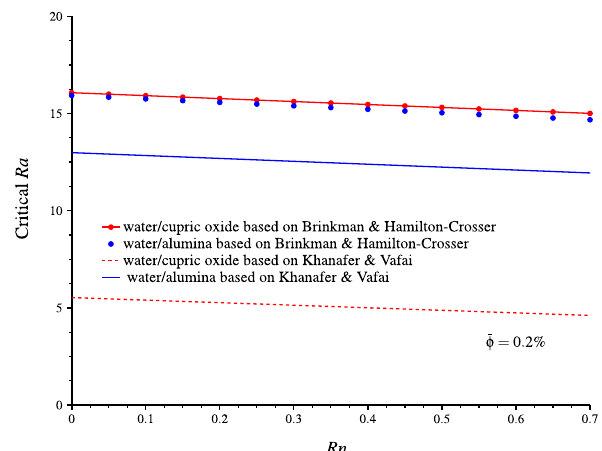
Figure 5: The relation between the concentration Rayleigh number and the critical thermal Rayleigh number for a DW/alumina nano fl uid and a DW/cupric oxide nano fl uid based on the model of Brinkman and Hamilton - Crosser and the model of Khanafer and